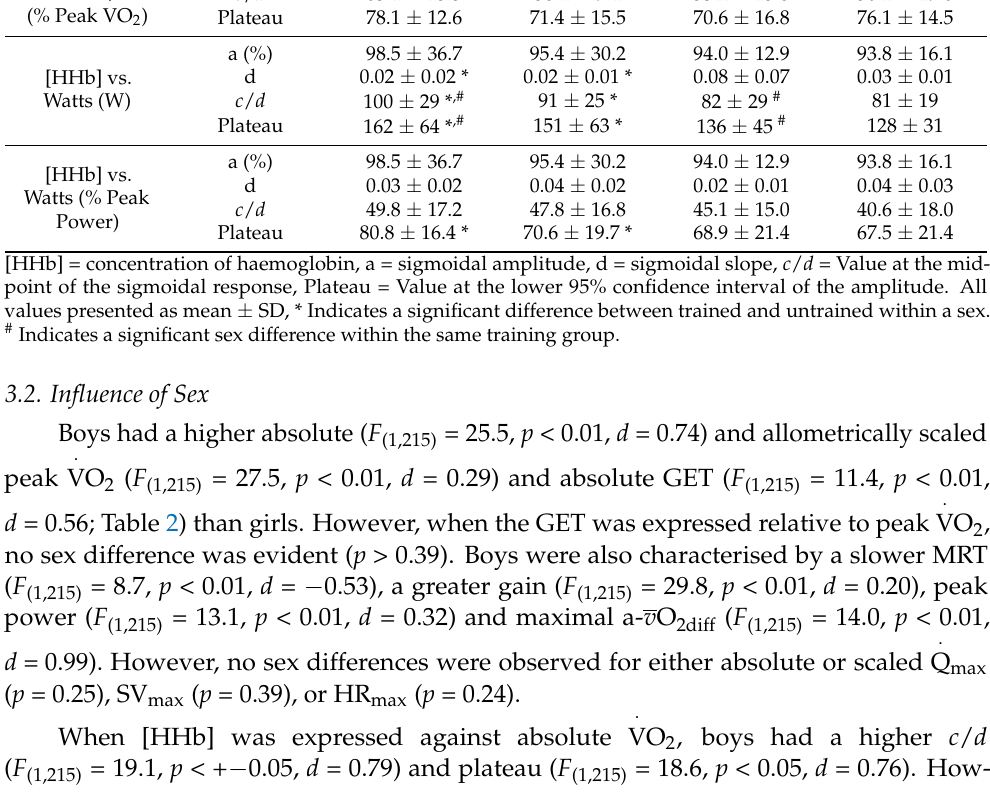
Table 3. Muscle deoxygenation variables from the incremental ramp exercise according to training status and sex. Trained Untrained Boys Girls Boys Girls [HHb] vs. · absolute VO